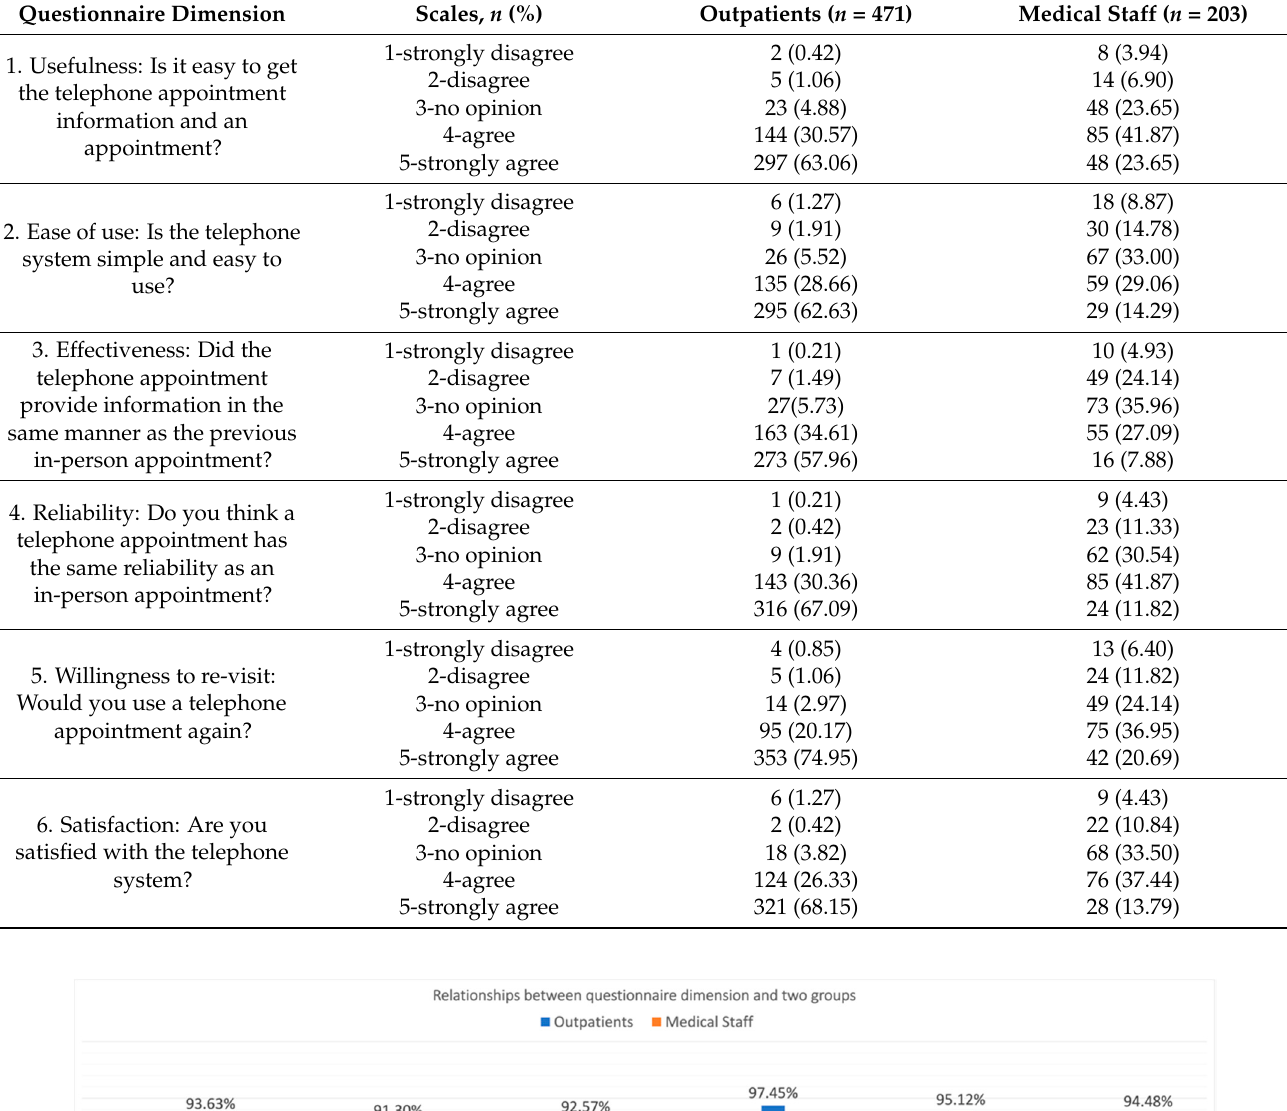
Table 3. Questionnaire dimensions of the participants who received telephone appointments during the COVID-19 pandemic in Taiwan.